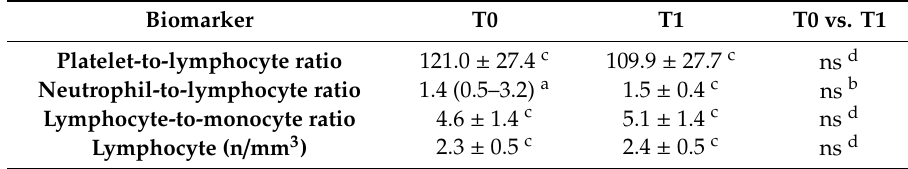
Table 11. Other biological markers of healthy subjects.